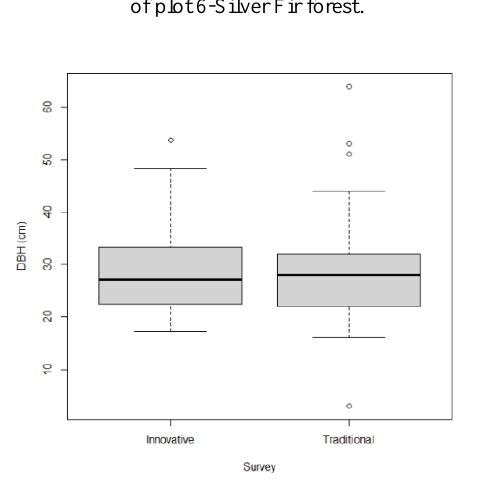
Figure 4.c Boxplots with resulting values for diameter at breast height (DBH) of plot 13-Beech forest.